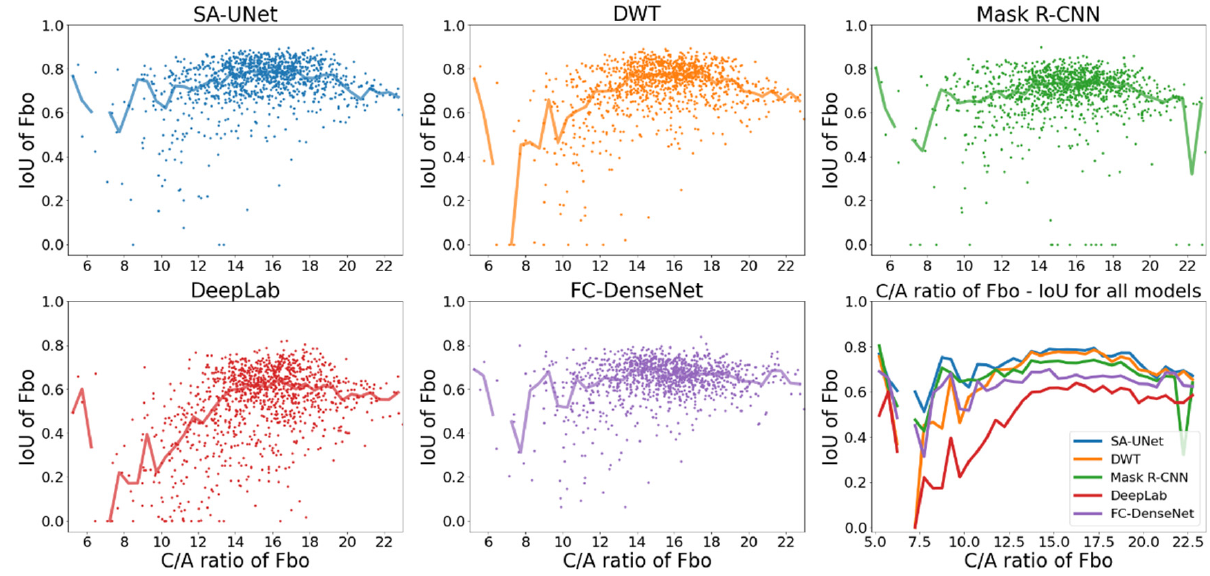
Figure 7. Comparison of IoU of Fbo vs. C/A ratio for all models (different colors represent different models: blue: SA-UNet, orange: DWT, green: Mask R-CNN, red: DeepLab, purple: FC-DenseNet).